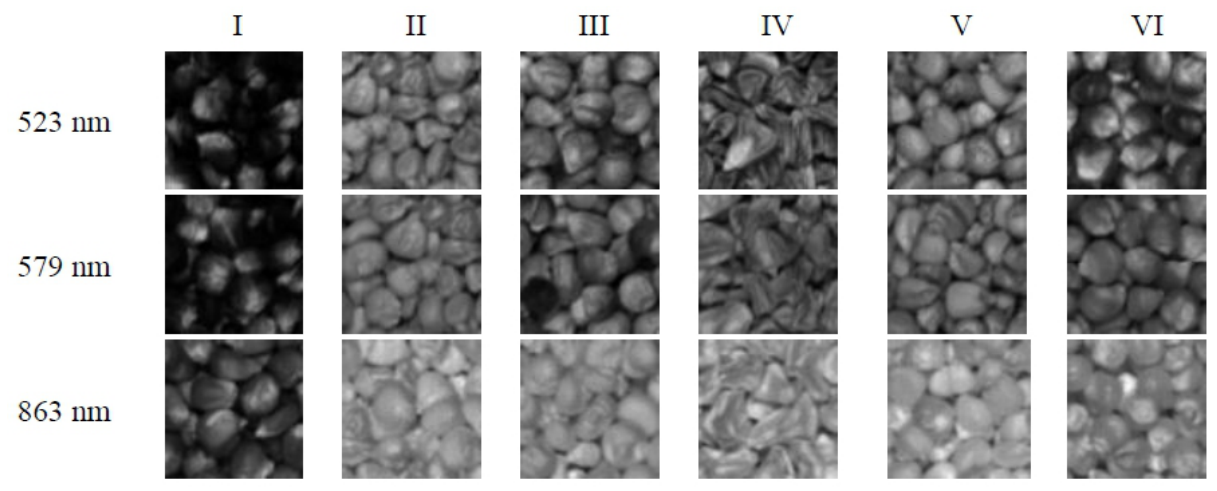
Figure 6. Monochrome images obtained using three selected optimal